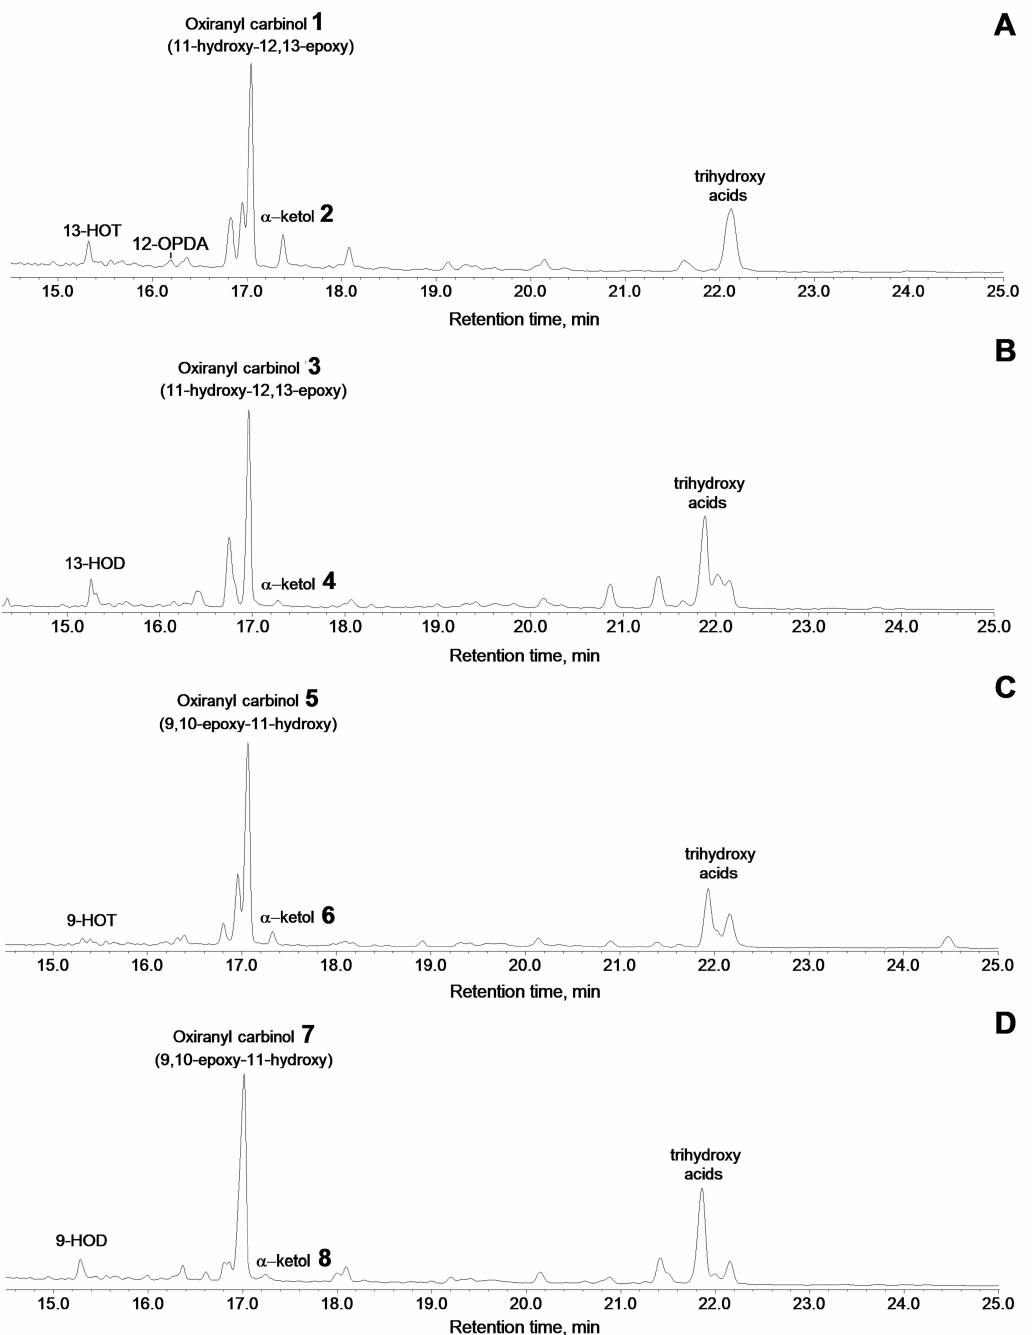
Figure 5. The total ion current GC–MS chromatograms of products (Me/TMS) of incubation of 13-HPOT ( A ), 13-HPOD ( B ), 9-HPOT ( C ), and 9-HPOD ( D ) with recombinant CYP440A18 enzyme. Conditions of incubation, extraction, derivatization, and analysis are described in the Materials and Methods section. The structural formulae of products are present at the Figure 4. 13-HOT, (9 Z ,11 E ,13 S ,15 Z )-13-hydroxy-9,11,15-octadecatrienoic acid; 13-HOD, (9 Z ,11 E ,13 S )-13-hydroxy-9,11- octadecadienoic acid; 9-HOT, (9 S ,10 E ,12 Z ,15 Z )-9-hydroxy-10,12,15-octadecatrienoic acid; 9-HOD, (9 S ,10 E ,12 Z )-9-hydroxy- 10,12-octadecadienoic